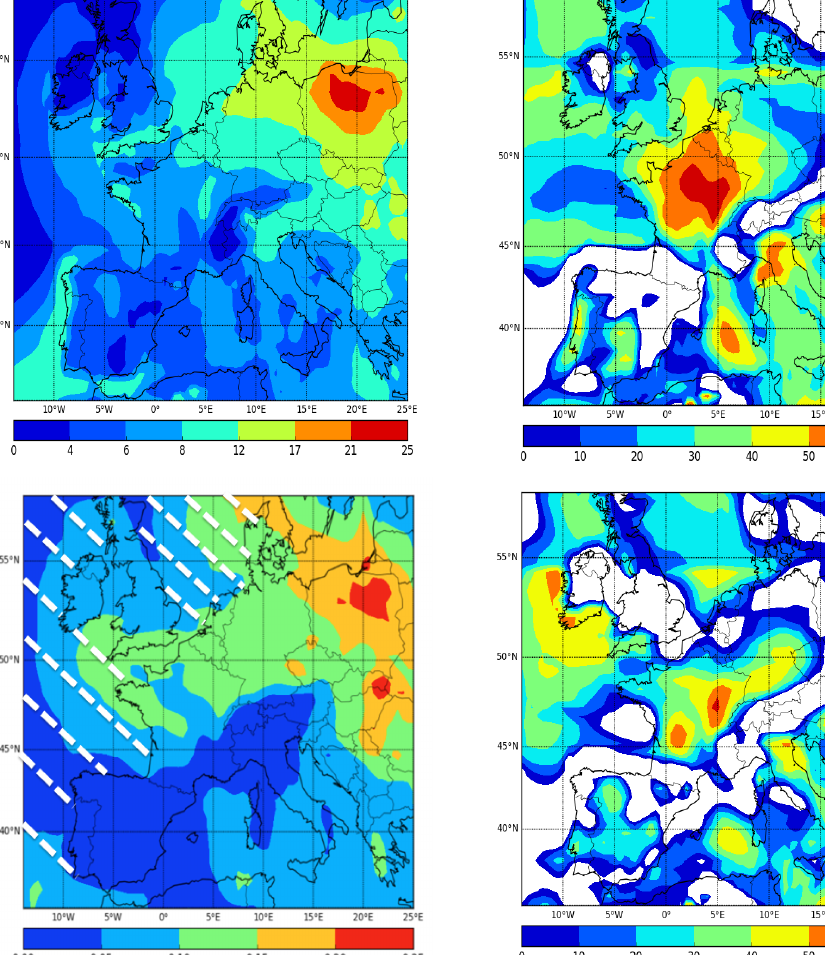
Figure 5. Maps of PM 2.5 concentrations ( upper left ), AOD field ( lower left panel ) and the relative difference between the simulations with and without objective analysis in terms of PM 2.5 concen- trations ( upper right panel ) and AOD field ( lower right panel ). The dashed area in the lower left figure represents the oceanic part of the simulated domain.